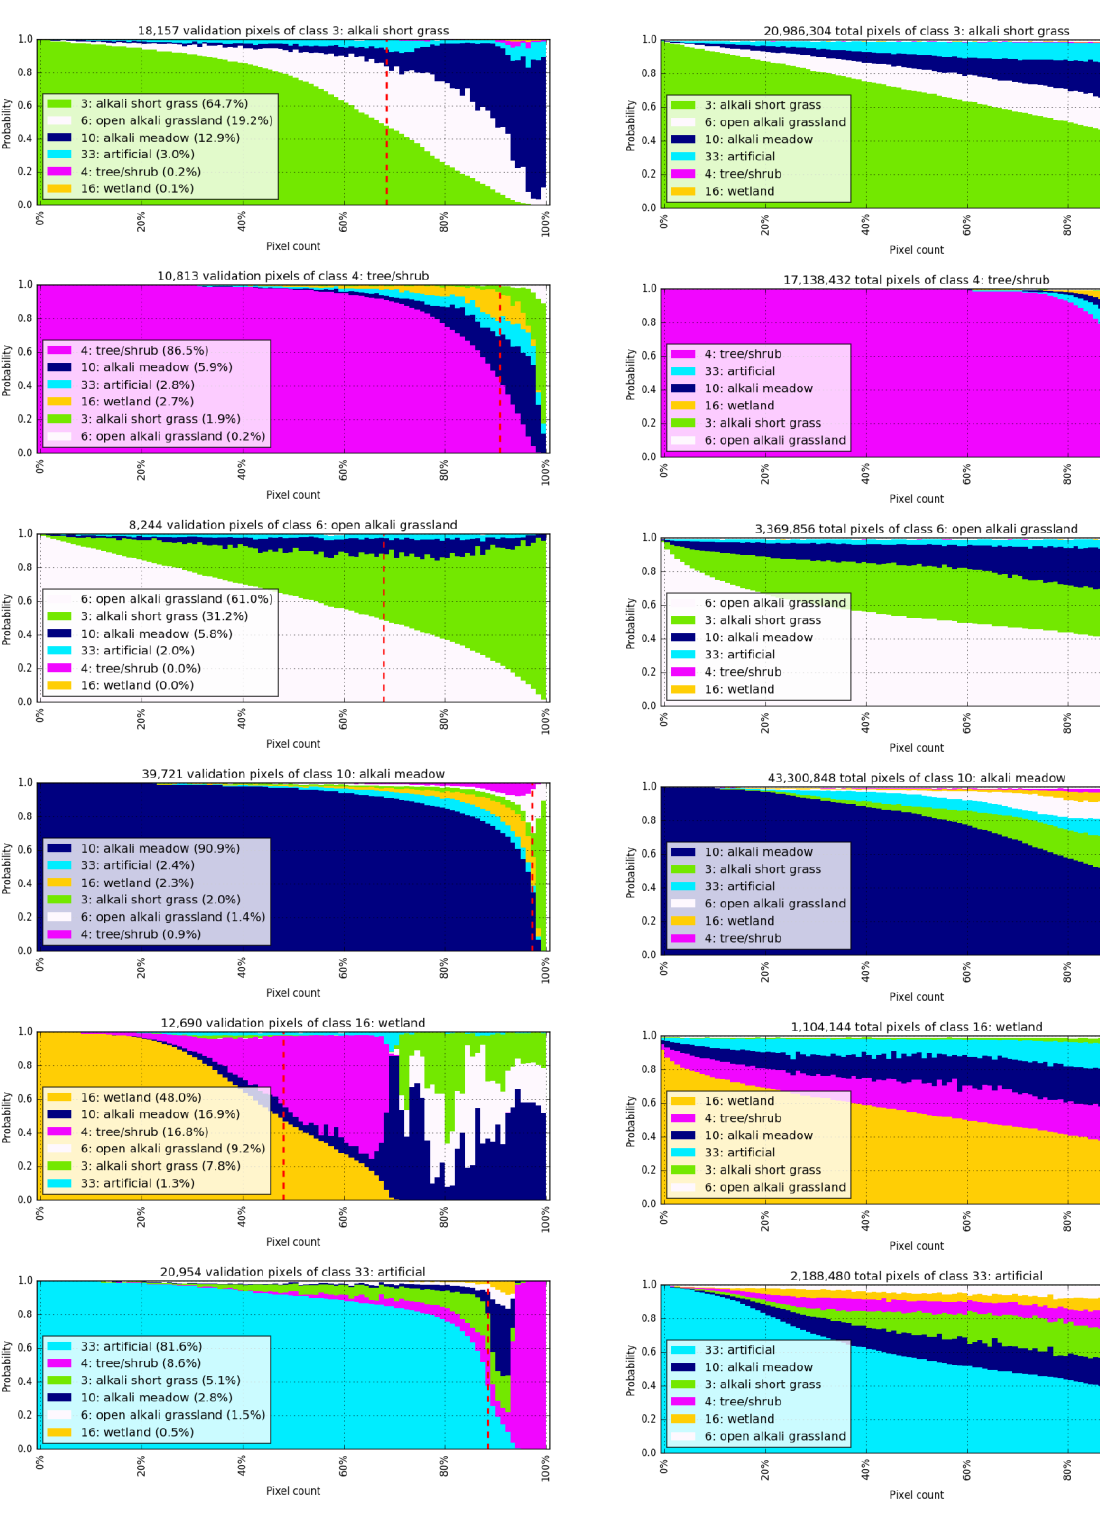
Figure 3. Dominance profile graphs for the validation pixels (left column) and for the whole study area (right column) for respective classes. The “dominance limit” is drawn as the red dashed vertical line in left-column